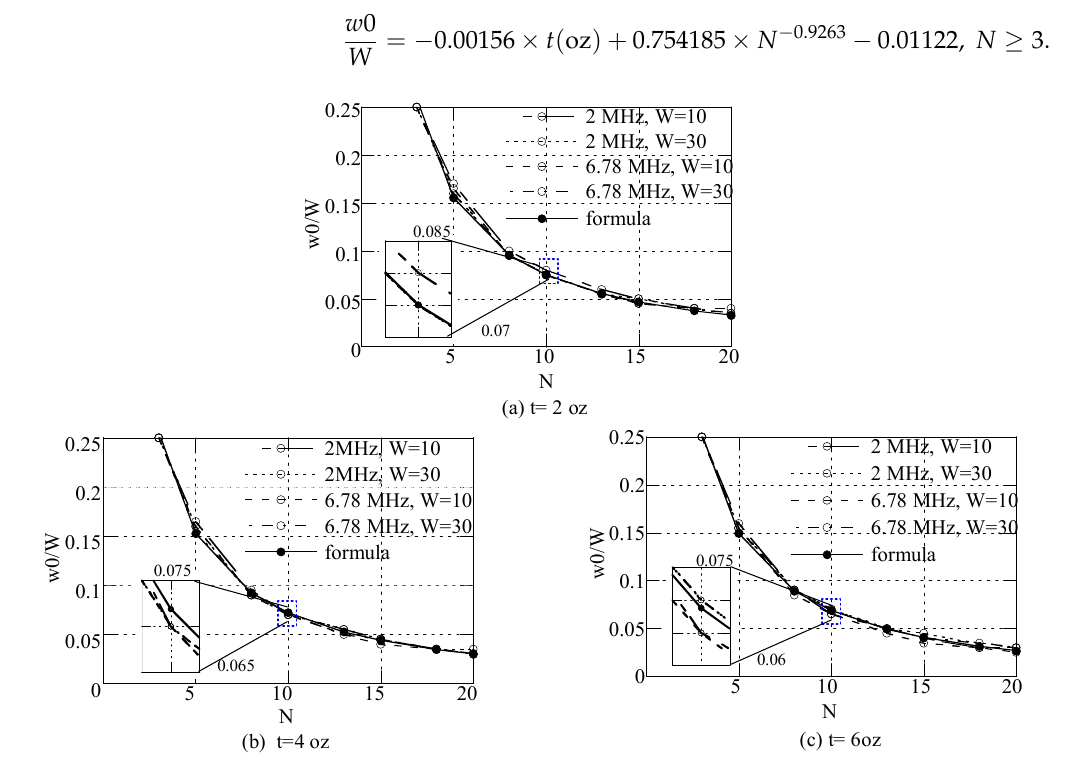
Figure 7. The formula’s optimal w 0/ W , calculated using (11), and comparison between the calcula- tions and formula results according to turn number N for the maximum Q-factor at frequencies of 2 MHz and 6.78 MHz, total pattern widths (W) of 10 mm and 30 mm, and metal thicknesses (t) of ( a ) 2 oz, ( b ) 4 oz, and ( c ) 6 oz.